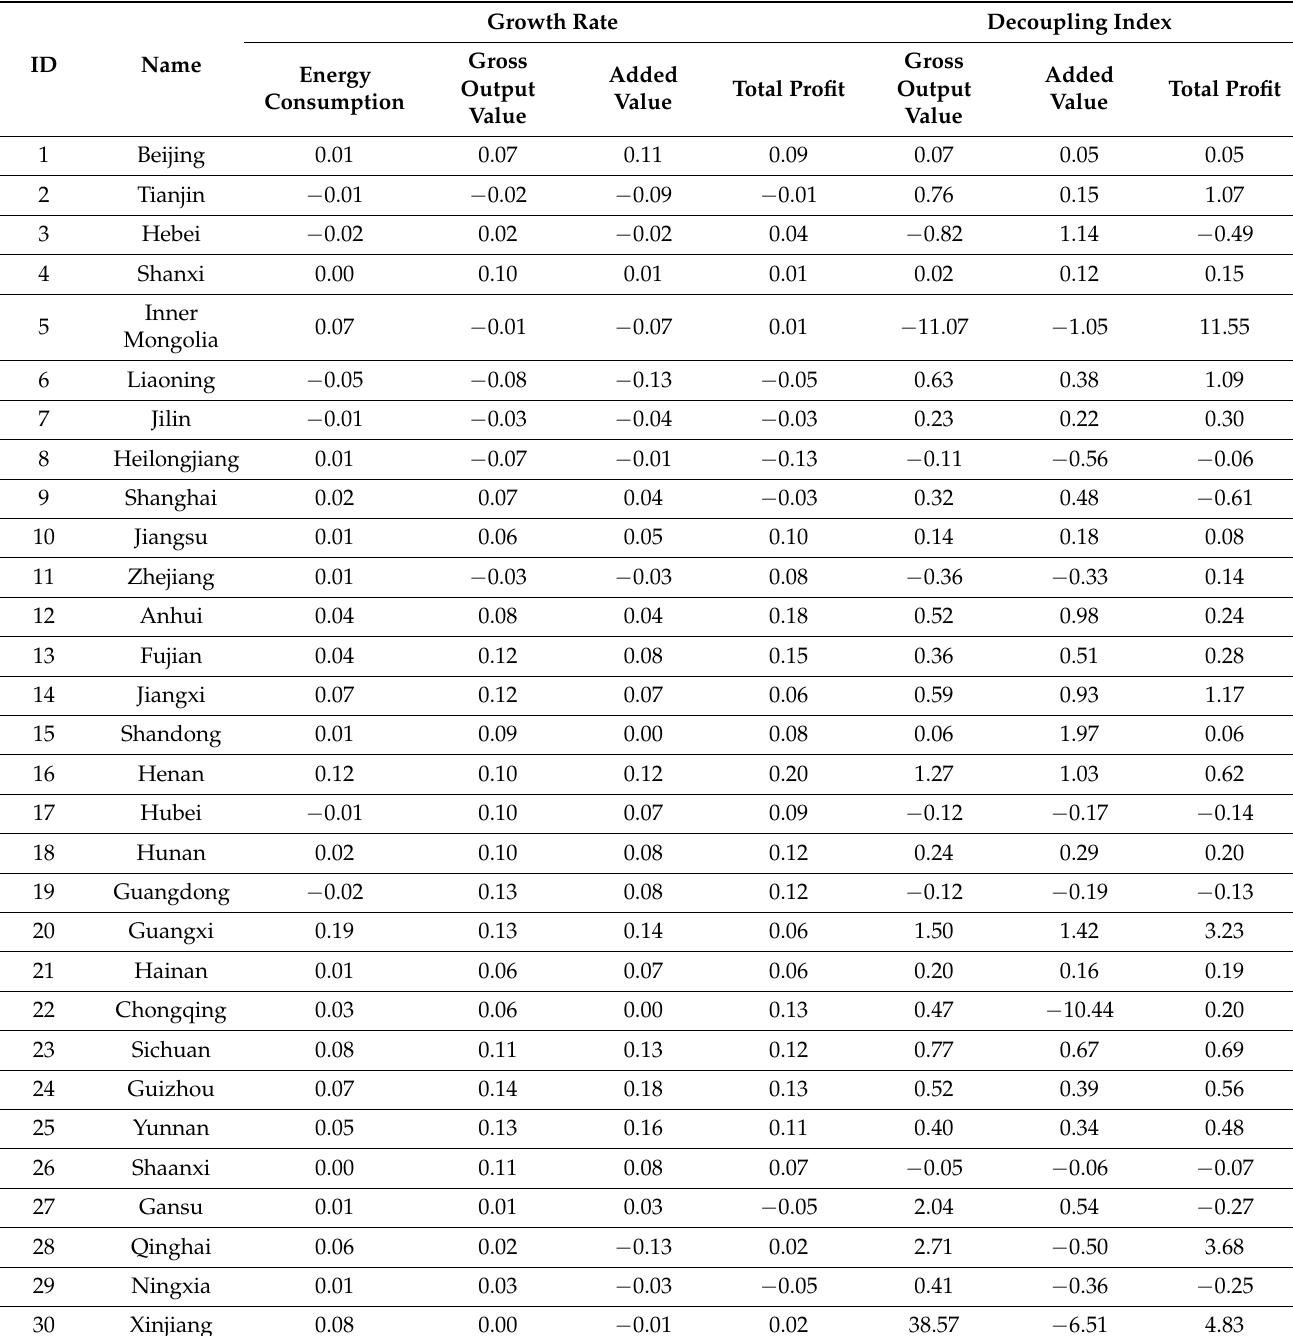
Table A2. Growth rate on construction energy consumption and construction economy and decou- pling index between the two from 2015 to